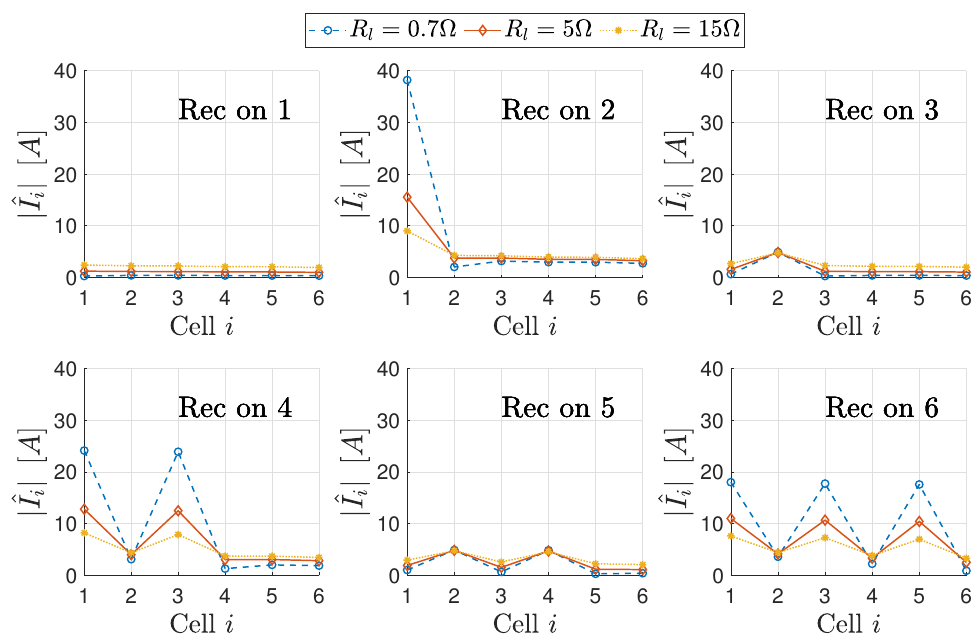
Figure 12. Standing wave patterns for different positions of the perfectly aligned receiver, a matched array and different load resistances.